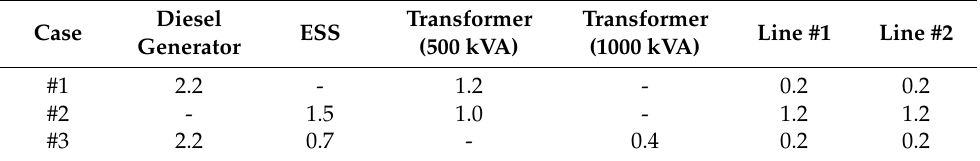
Table 5. Coordination results of lever (delay) for isolated microgrid.